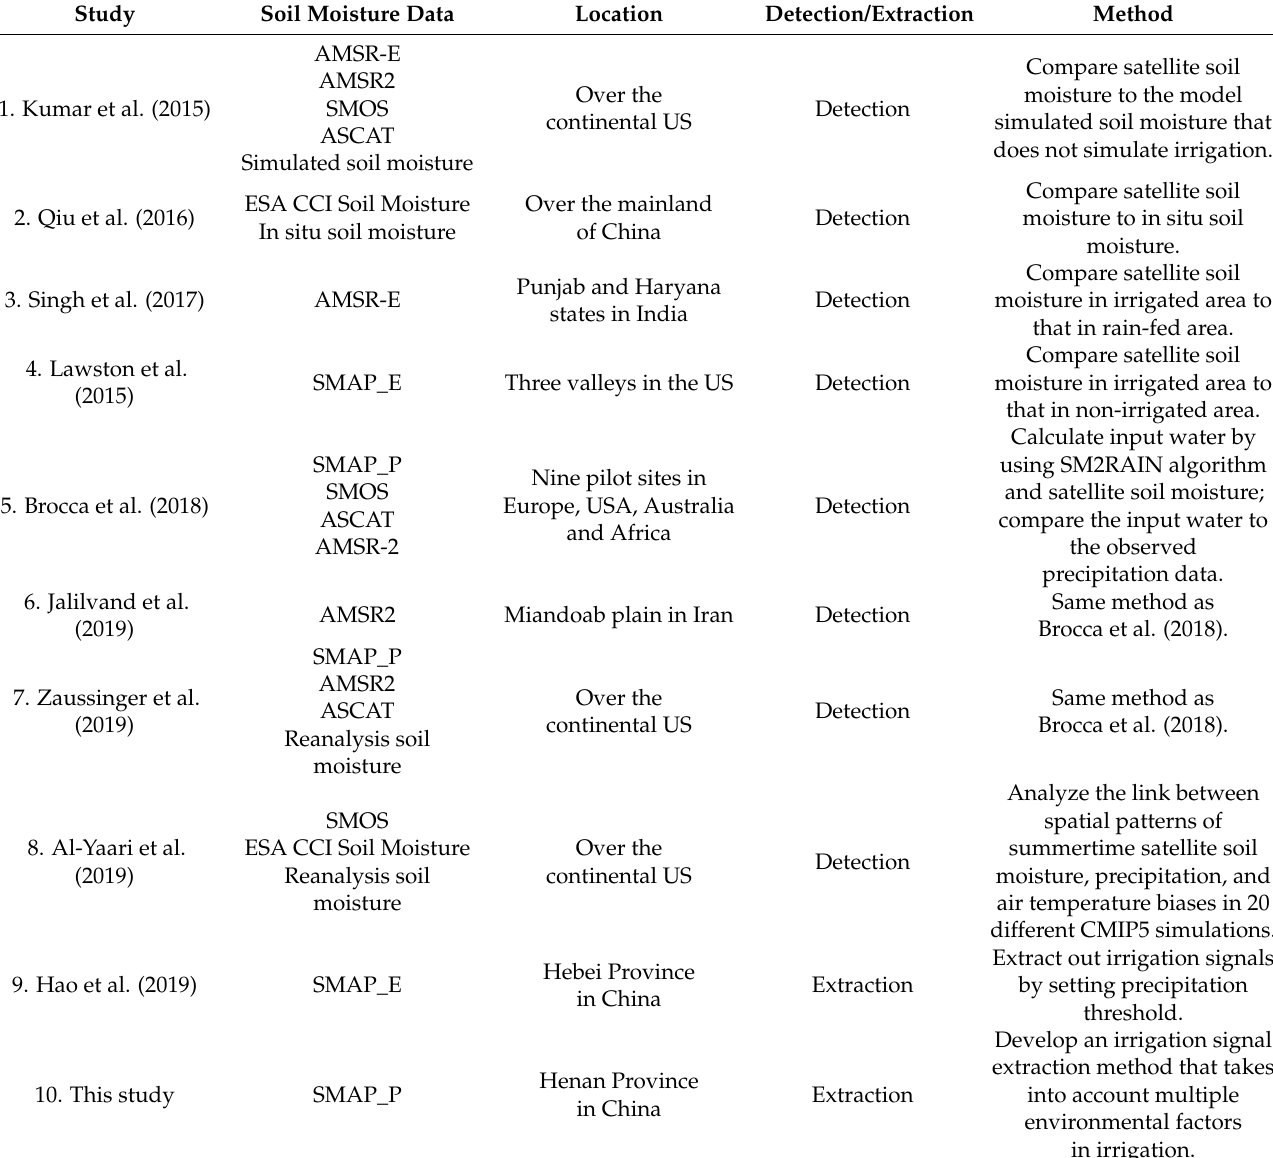
Table 1. Key papers for detection/extraction of irrigation signals from satellite-based soil